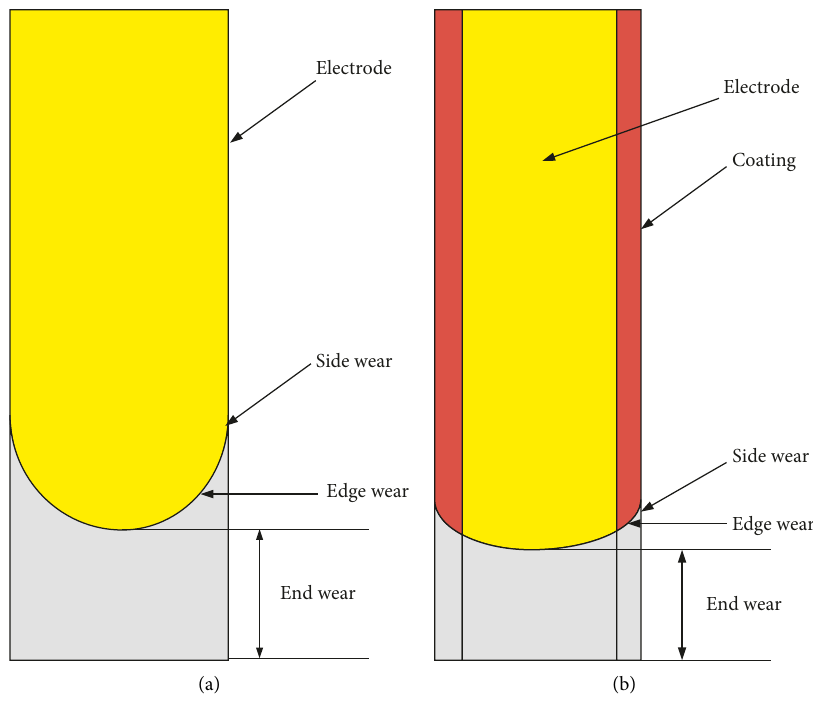
Figure 1: Comparison of (a) common tool wear and (b) coated tool wear.